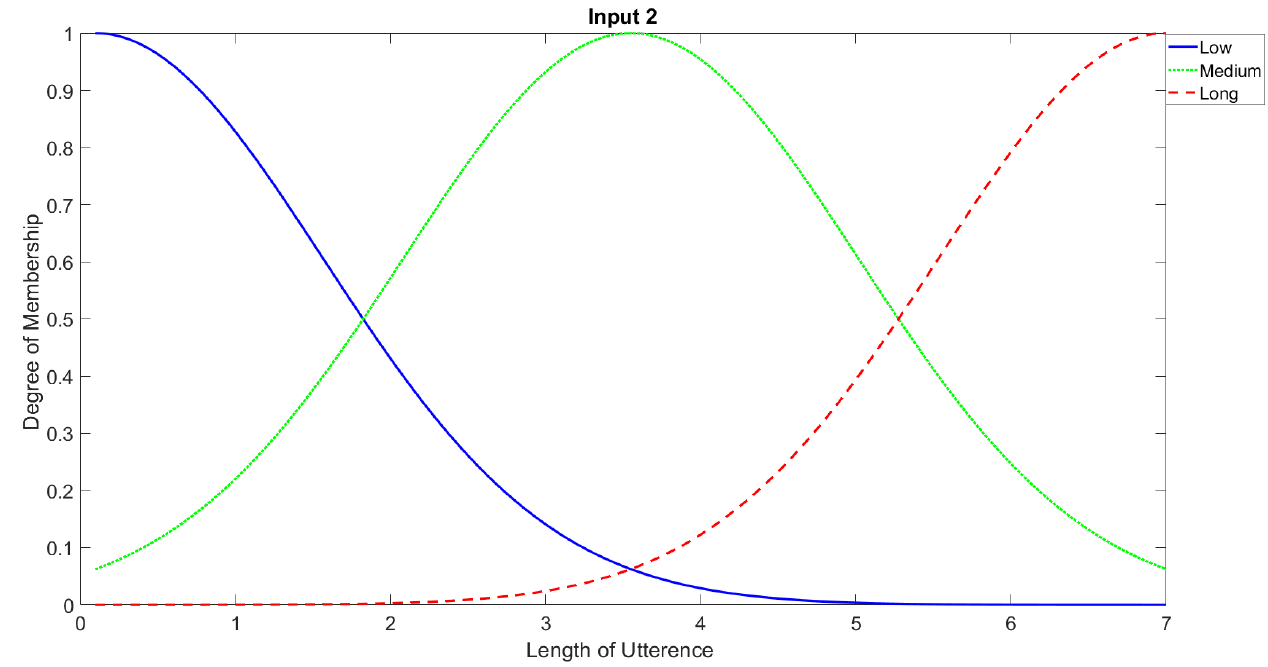
Figure 9. Fuzzy membership function for length of utterance input.